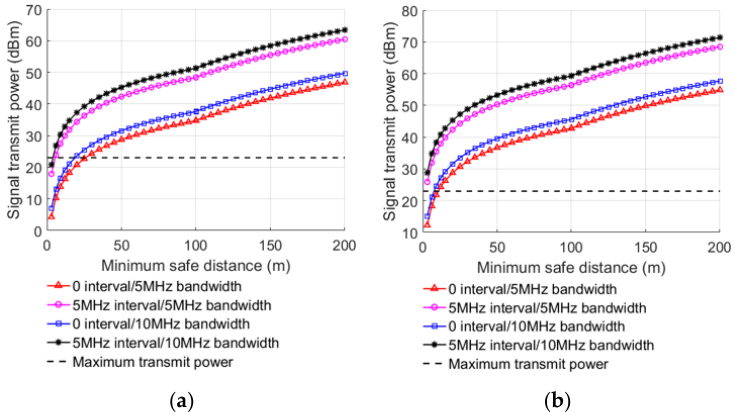
Figure 3. Minimum safe distance with the transmit power of interfering signal at different UE positions when UE interfering with BS: ( a ) platform, ( b ) carriage.